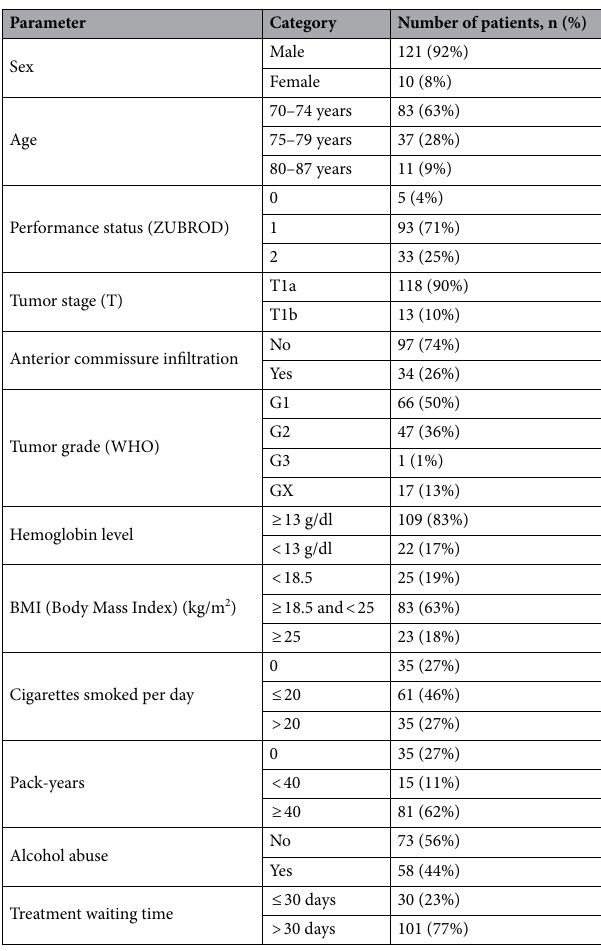
Table 7. Clinical characteristics of patients with T1 glottic cancer aged 70 and above. GX grade was not assessed.